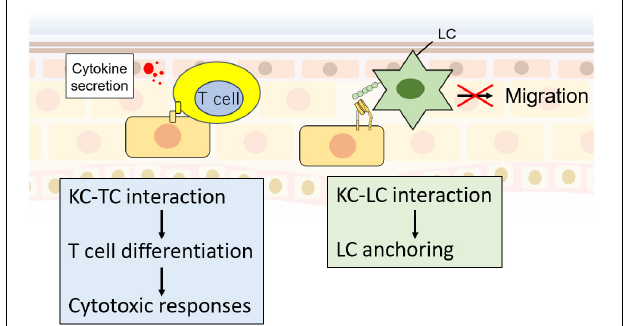
FIGURE 3 | KC interaction with T cells (TCs) and LCs. KCs interact with TCs via CD2 and CD54, which promote TC differentiation. Differentiated TCs promote cytotoxic responses. In contrast, KC–LC interactions via E-cadherin and integrins decrease LC migration activity the to lymph